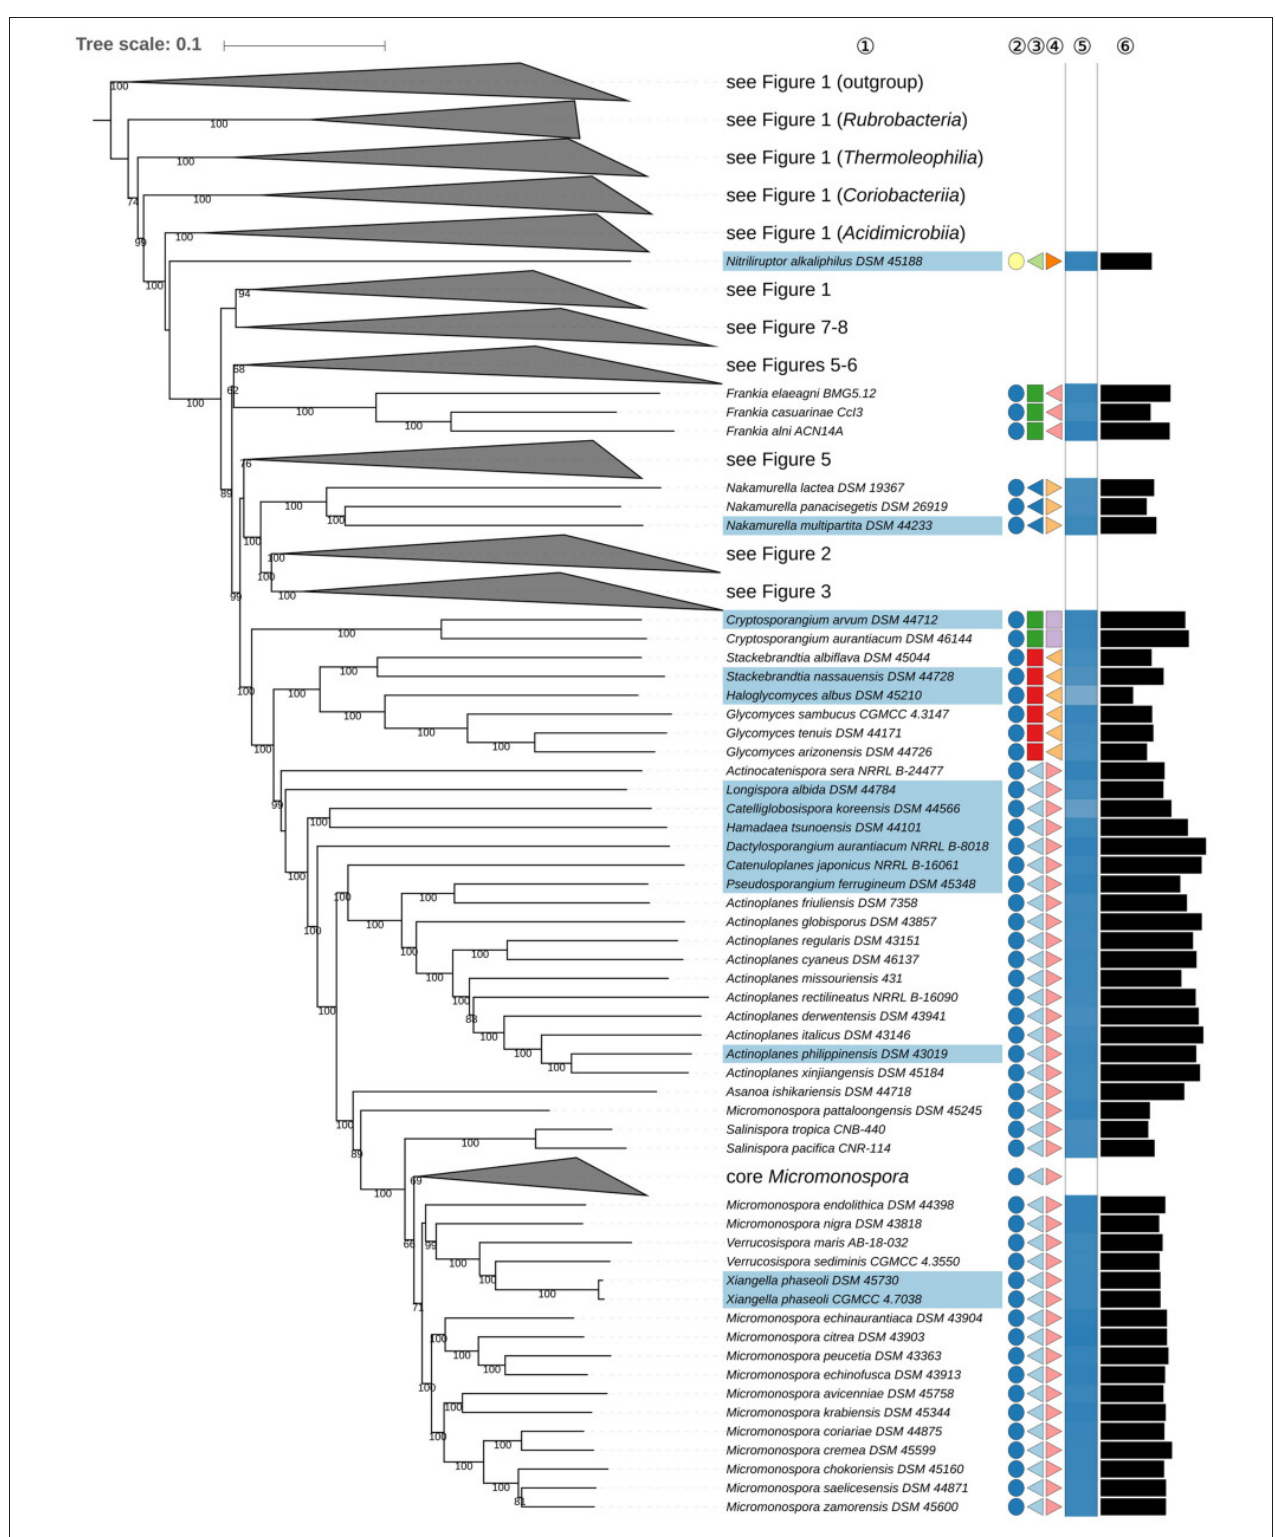
FIGURE 4 | Fourth part of the phylogenomic tree inferred with GBDP. A detailed description is provided in the caption of Figure 1 . The parts of the tree which have been collapsed here are shown in other figures as indicated.